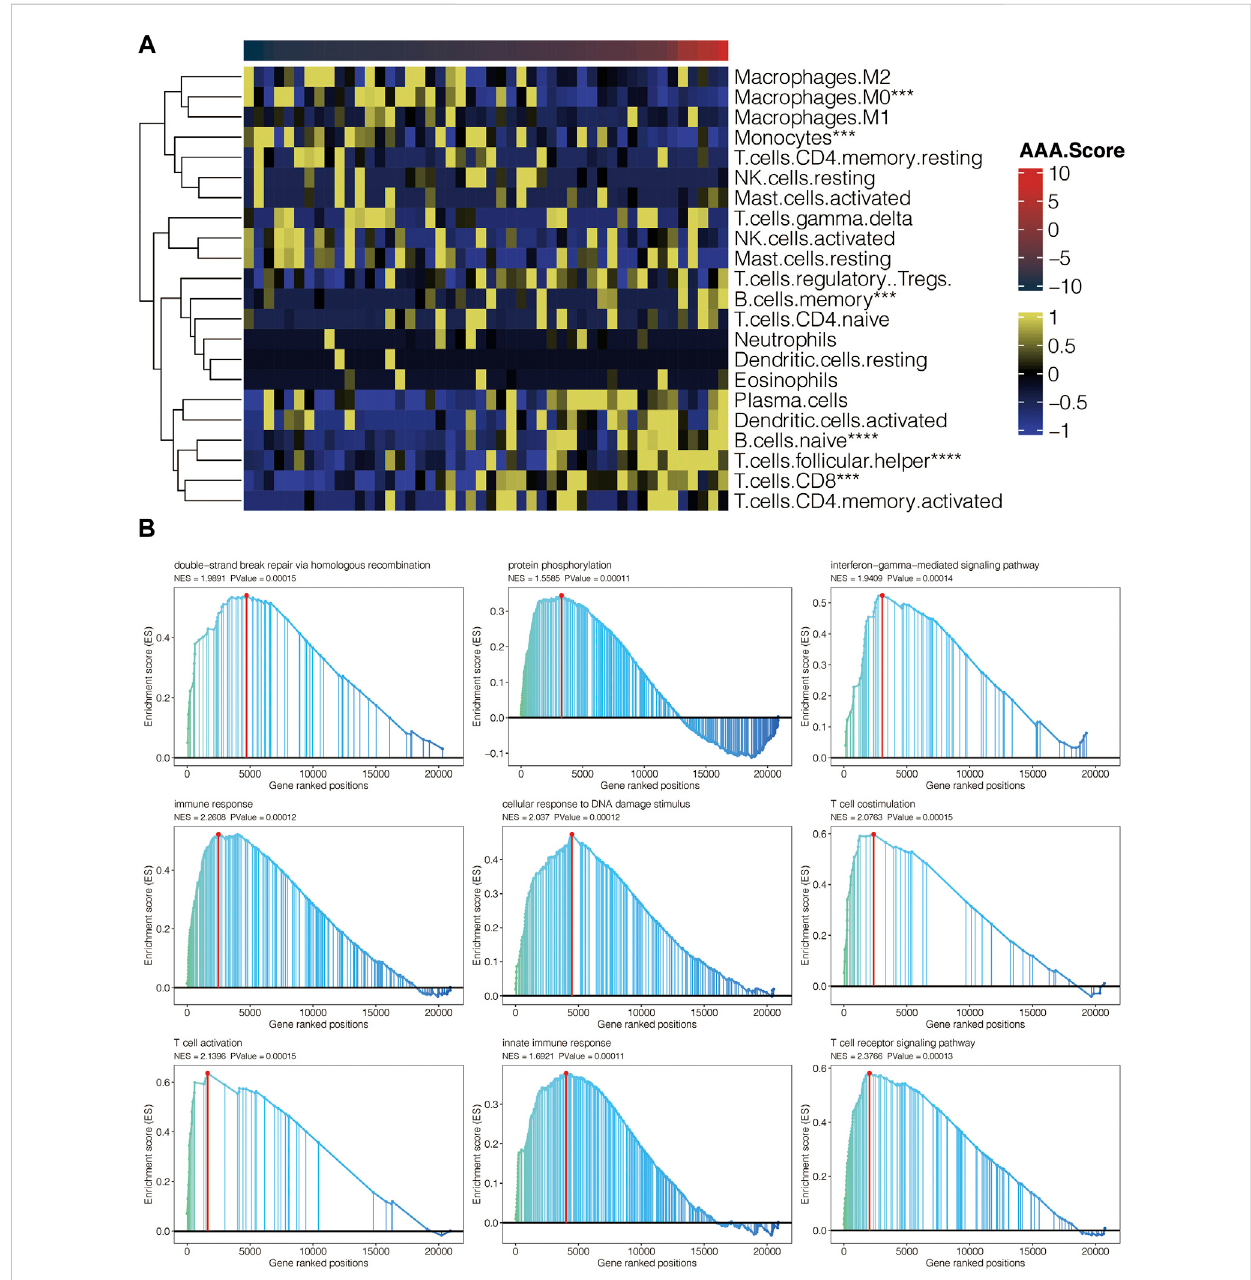
FIGURE 8 Immune characteristics of AAA-related score. (A) Heatmap for the association between AAA-related score and CIBERSORT-based immune cells in GSE98278. (B) GSEA for GO pathways related to AAA-related score in